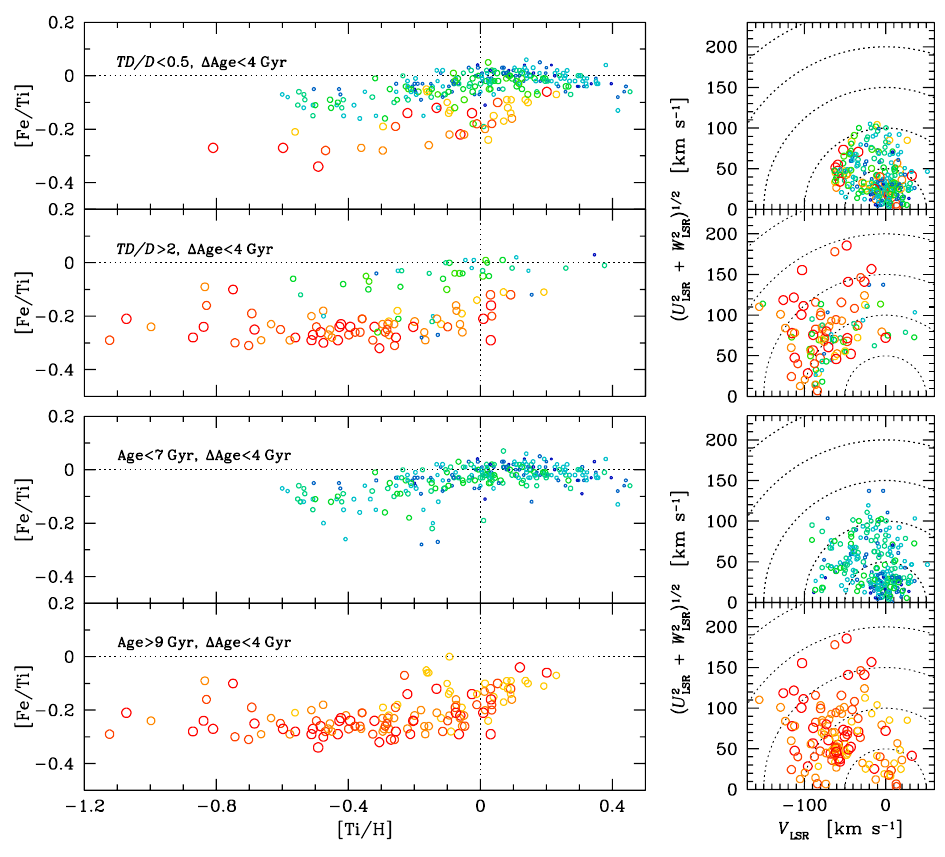
Figure 2. Upper left: [Fe/Ti]-[Ti/H] abundance trends when using the kinematical criteria from [8, 9]; lower left: when using age criteria. Right: Toomre diagrams for the samples on the left-hand side. Only stars with a difference between upper and lower age estimates less than 4Gyr are shown. Stars have been colour- and size coded depending on their ages (blue and small circles represent young stars, red and big circles represent old